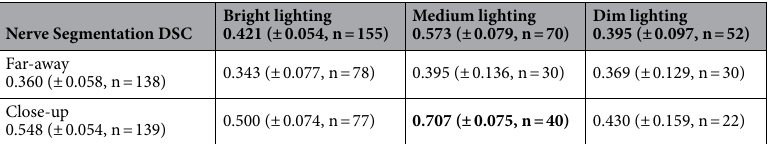
Table 1. Quantitative nerve segmentation results. Quantitative results of micro-averaged segmentation dice similarity coefficient (DSC) across all 5 cross-validation test folds. Evaluation examines all combinations of image conditions (picture distance and brightness) with 95% confidence intervals. Confidence intervals are calculated using the standard error of the n averaged dice scores. Best-performing condition is bolded. The algorithm had the best performance on images that were close-up to the surgical anatomy and had medium